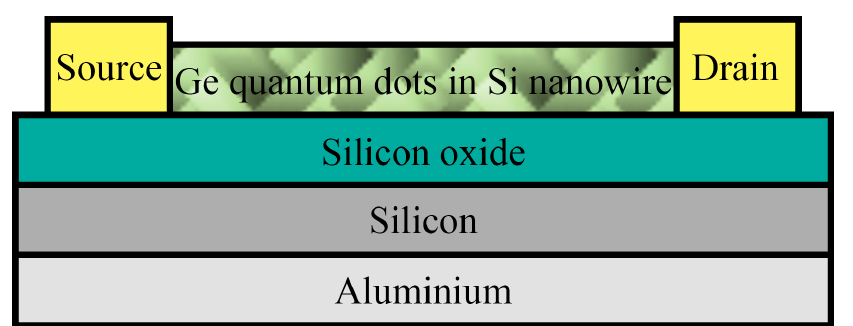
Figure 10. Schematic diagram of phototransistor with single Si nanowire decorated with Ge quantum dots.